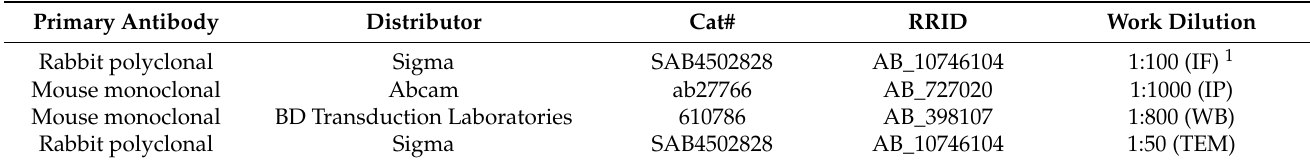
Table 1. Technical comparison among the anti- α -syn primary antibodies used in this